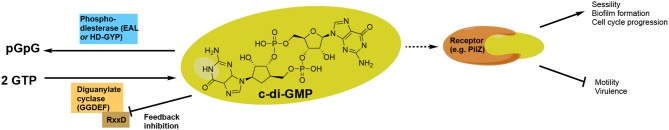
Graphical illustration of c-di-GMP signaling.